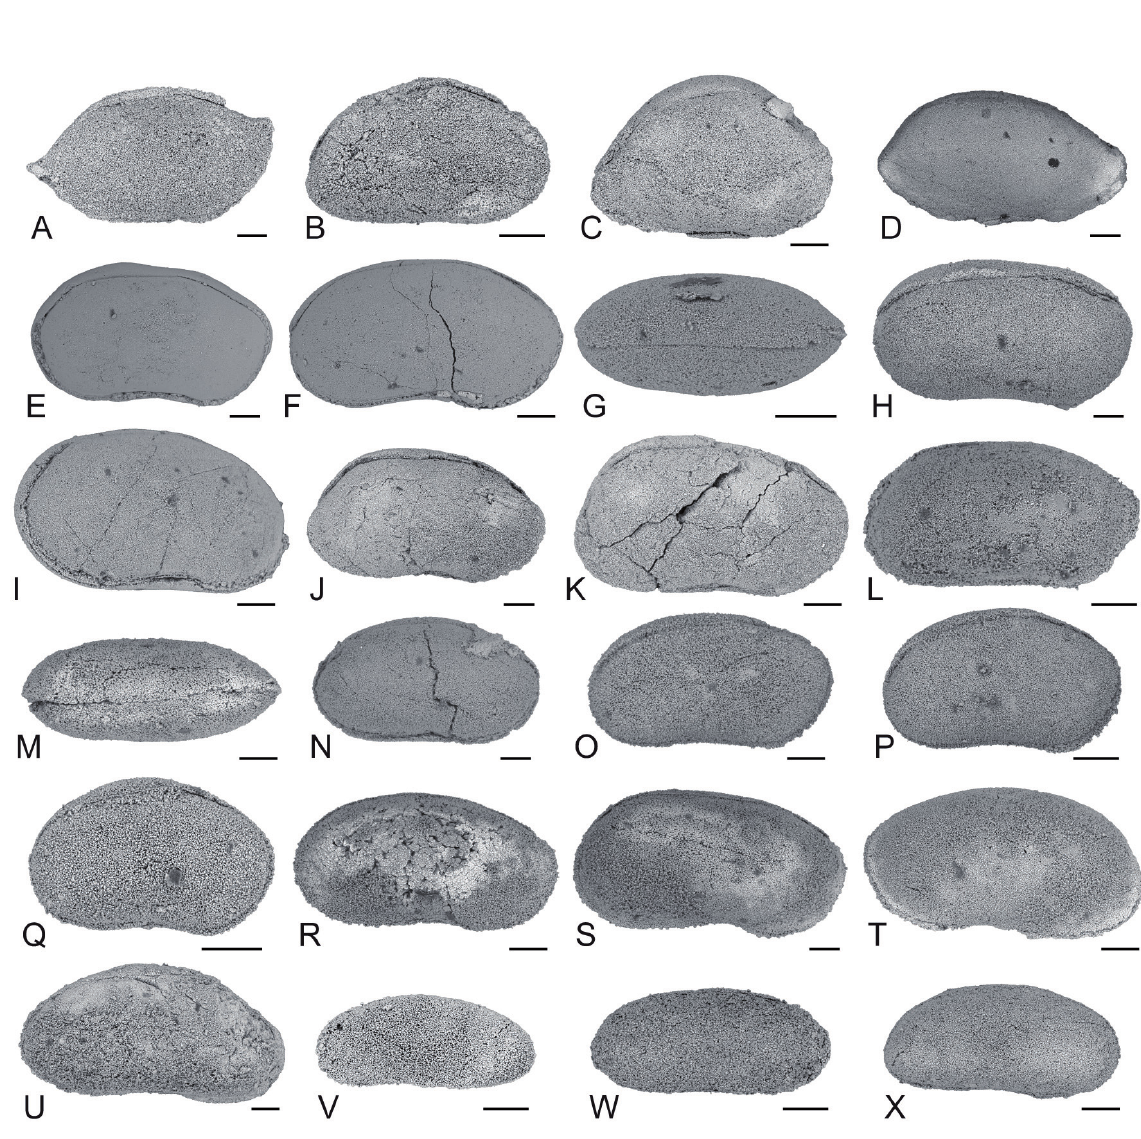
Fig. 10. Ostracods from the Dajiang section, South China. — A . Bairdia sp. 33, carapace, right lateral view, P6M3034. — B . Bairdia sp. 34, carapace, right lateral view, P6M3035. — C . Bairdia sp. 35, carapace, right lateral view, P6M3036. — D . Bairdia ? sp. 36, carapace, right lateral view, P6M3037.